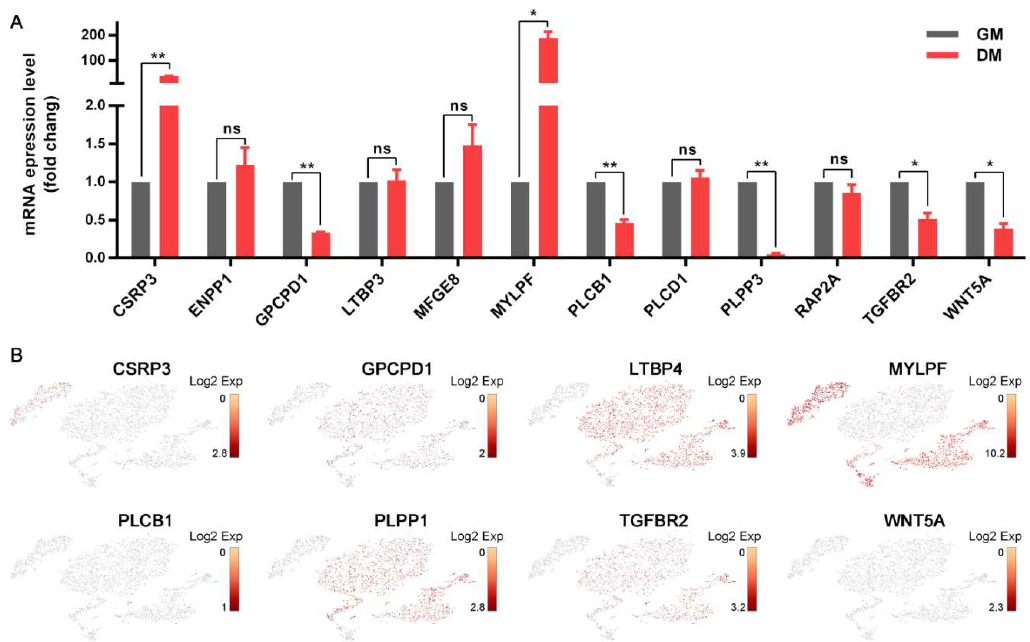
Figure 6. The proteins connecting ion homeostasis with cell differentiation and muscle development. The mRNA expressions of their corresponding genes during myogenic differentiation ( A , n = 6) and among the subpopulations of Myo-lineage cells ( B ). * means p < 0.05, and ** means p < 0.01. GM, growth medium, representing cells cultured in growth medium before myogenic induction; DM, differentiation medium, representing cells at 4th day during myogenic differentiation cultured in differentiation medium.